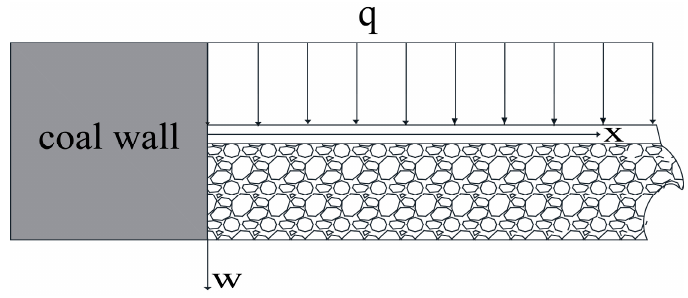
Figure 9. Structural mechanics model.